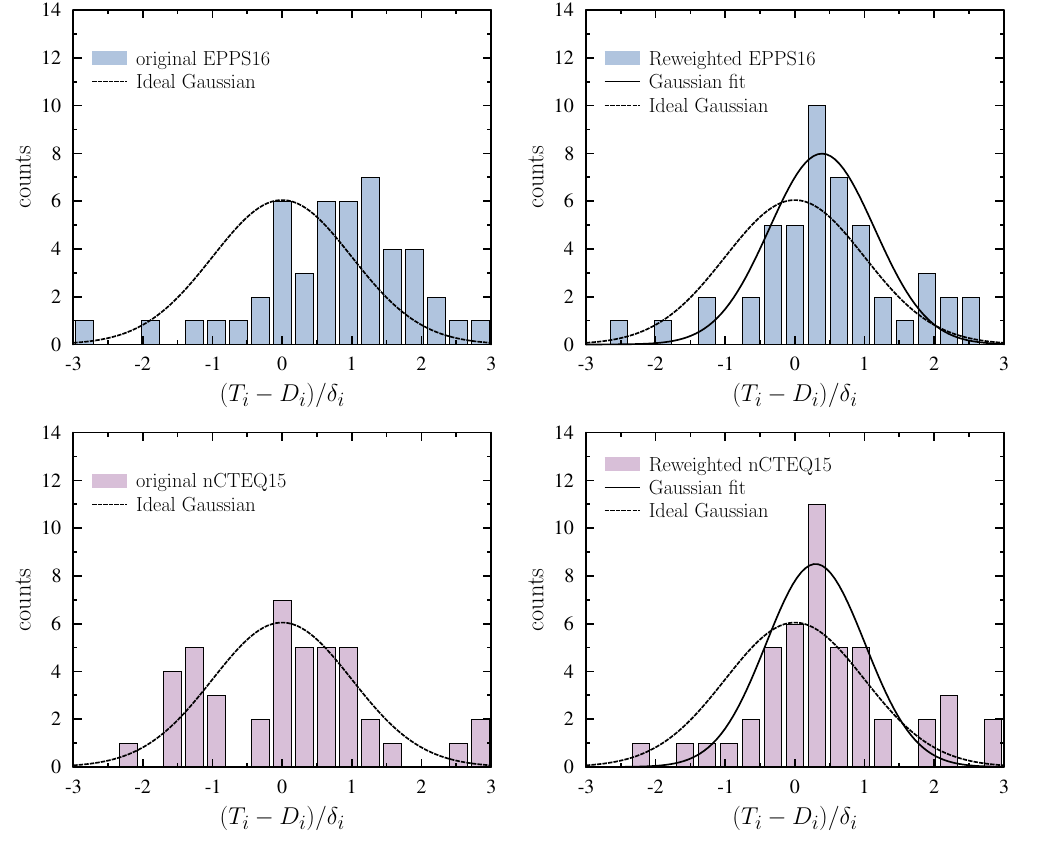
Figure 5 . The histograms of the R D 0 -data residuals obtained before (left) and after (right) the pPb reweighting with EPPS16 (top) and nCTEQ15 (bottom). Ideal Gaussian distributions (dashed) are compared to (cid:12)tted ones (solid) in the reweighted